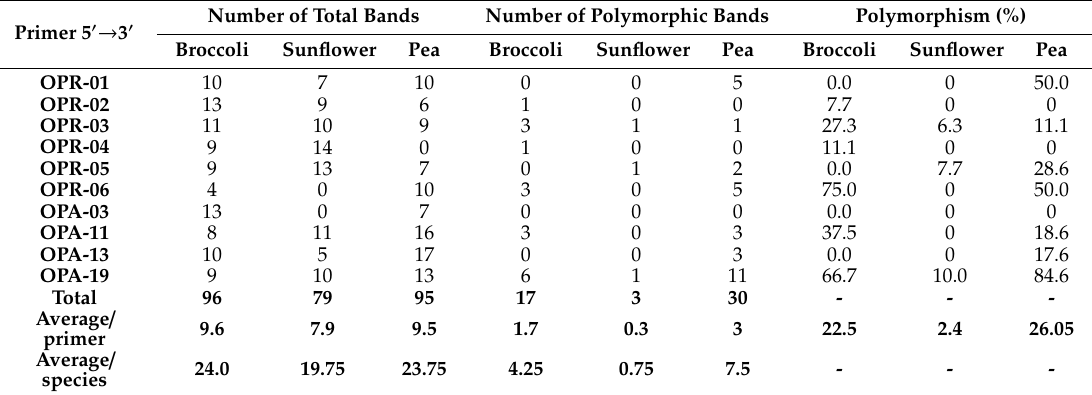
Table 3. Total number of fragments and number of polymorphic fragments generated by random amplification of polymorphic DNA (RAPD) primers. Sprouts were obtained via enrichment of seeds with Zn0, Zn10, Zn20 and Zn30.